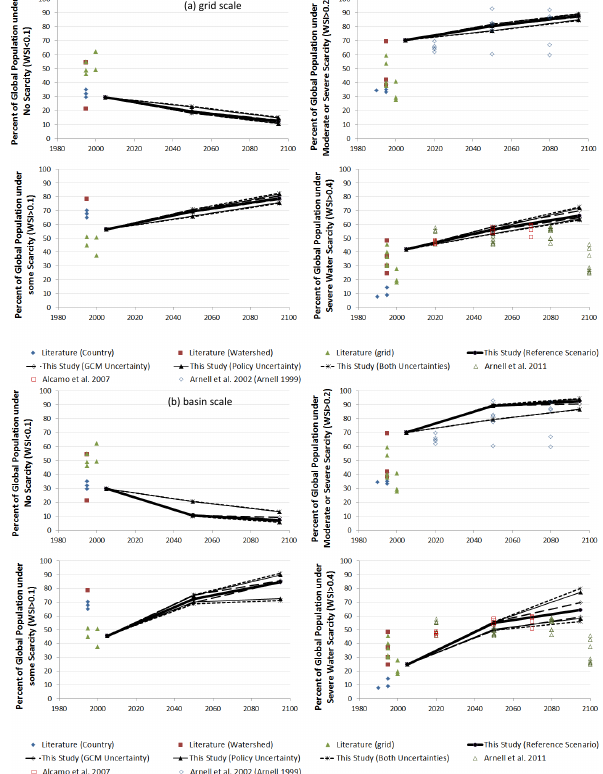
Figure 19: Comparison of the estimated percent of global population living different thresholds of water scarcity conditions with previous estimates from the literature (Wada et al., 2011 and references therein, Arnell et al. 2002 & 2011, and Alcamo et al., 2007); the spread in our results reflect the uncertainty arising from relying on each of the GCMs separately and the various climate policies, both singly and in tandem; the shape denotes the spatial scale of estimating WSI (blue diamonds: country scale; red squares: watershed scale; and green triangles: grid scale); solid points reflect assessments of current or historical scarcity conditions; empty shapes denote projections in the future